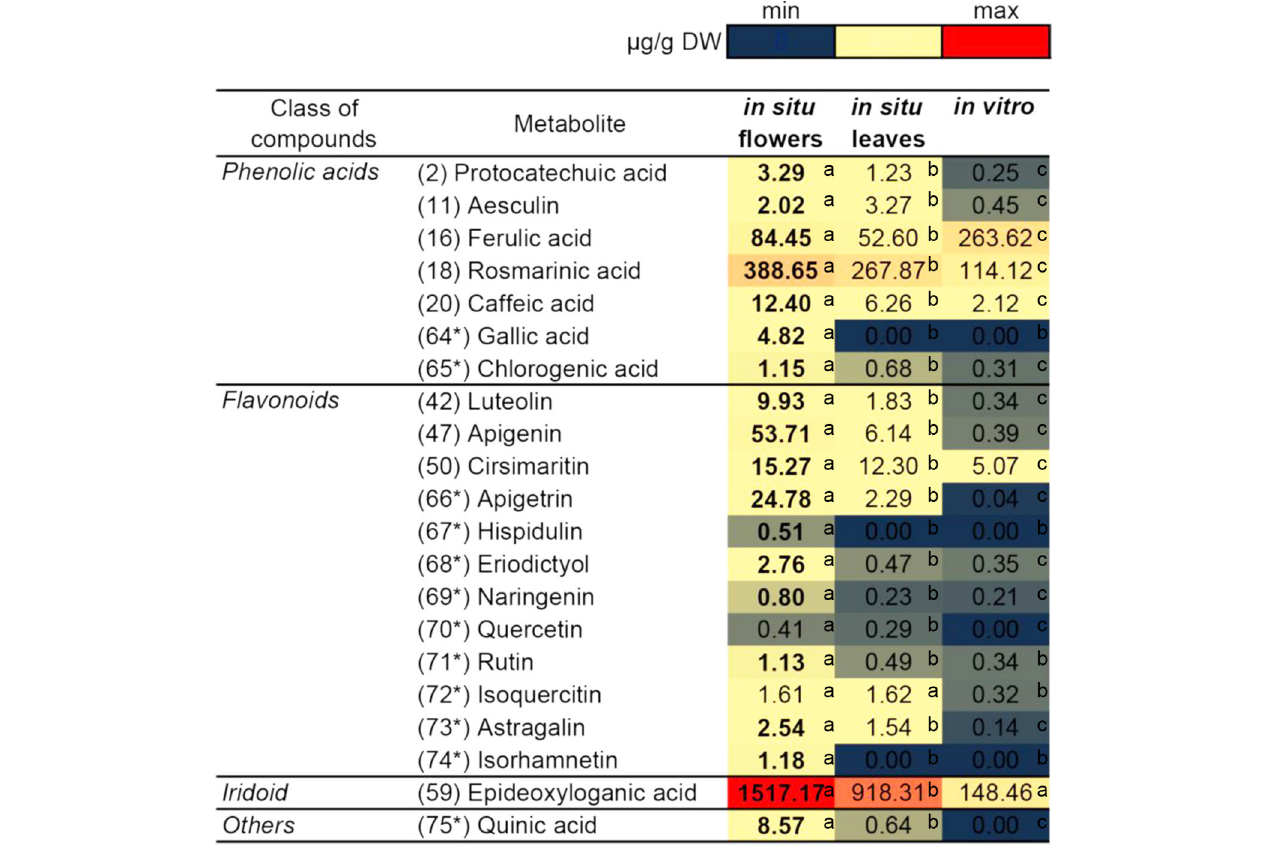
of the genus Nepeta , as compared to ribosomal